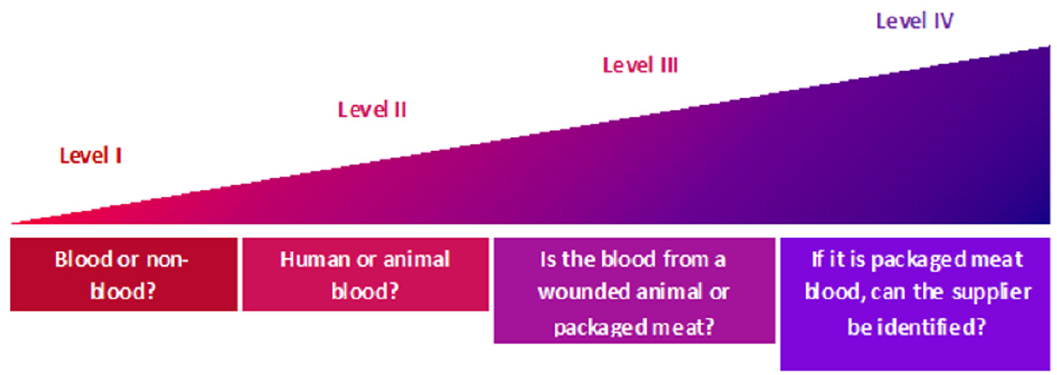
Figure 1. Schematics of the possible levels of identification for the detection of human and animal blood using the bottom-up proteomic MALDI MS based approach. Revised from Kennedy et al. [7]. The ability to ascertain whether animal blood derived from a wounded animal at the scene or from someone handling raw meat may be important to some investigations. In the latter case, as an example, this information would have been helpful in the UK murder case of Susan May (Regina vs. Susan May), to corroborate or disprove her statement, claiming that if blood was indeed present in her fingerprint on the bedroom’s wall, it would have been of animal origin, and specifically from raw packaged meat, due to her handling it to prepare lunch for her aunt.